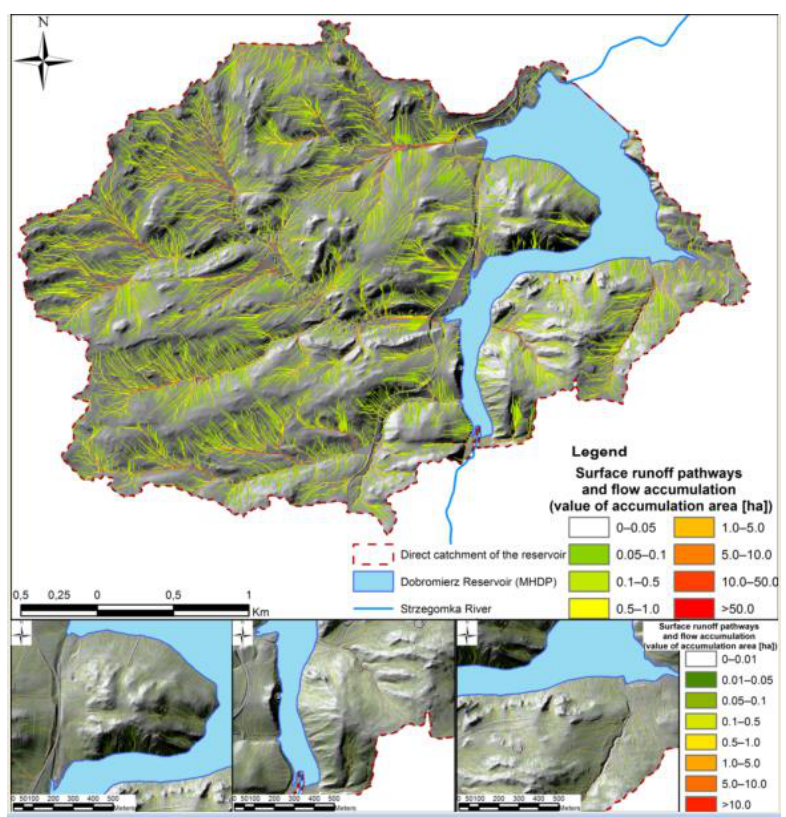
Figure 4. Flow accumulation map of the direct catchment of the Dobromierz Reservoir—flow accumulation counted from junction to junction.